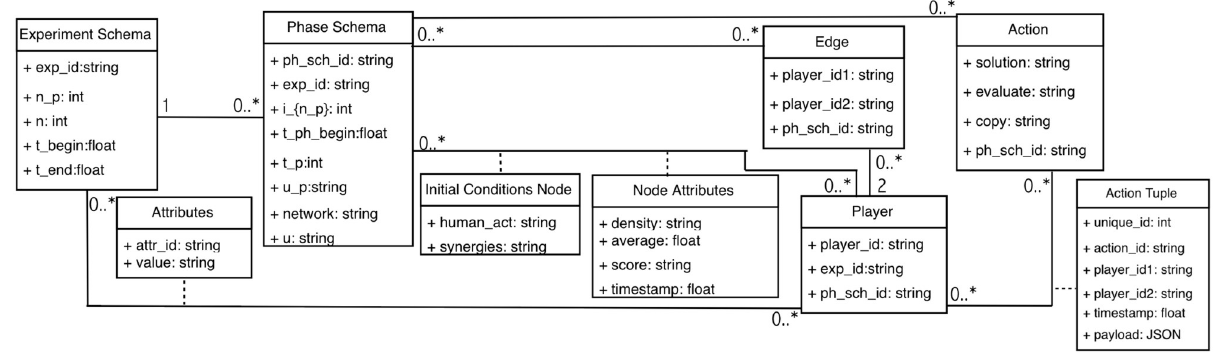
Fig 34. Data model of Table 15 translated into a entity-relationship diagram in Unified Modeling Language (UML) form.